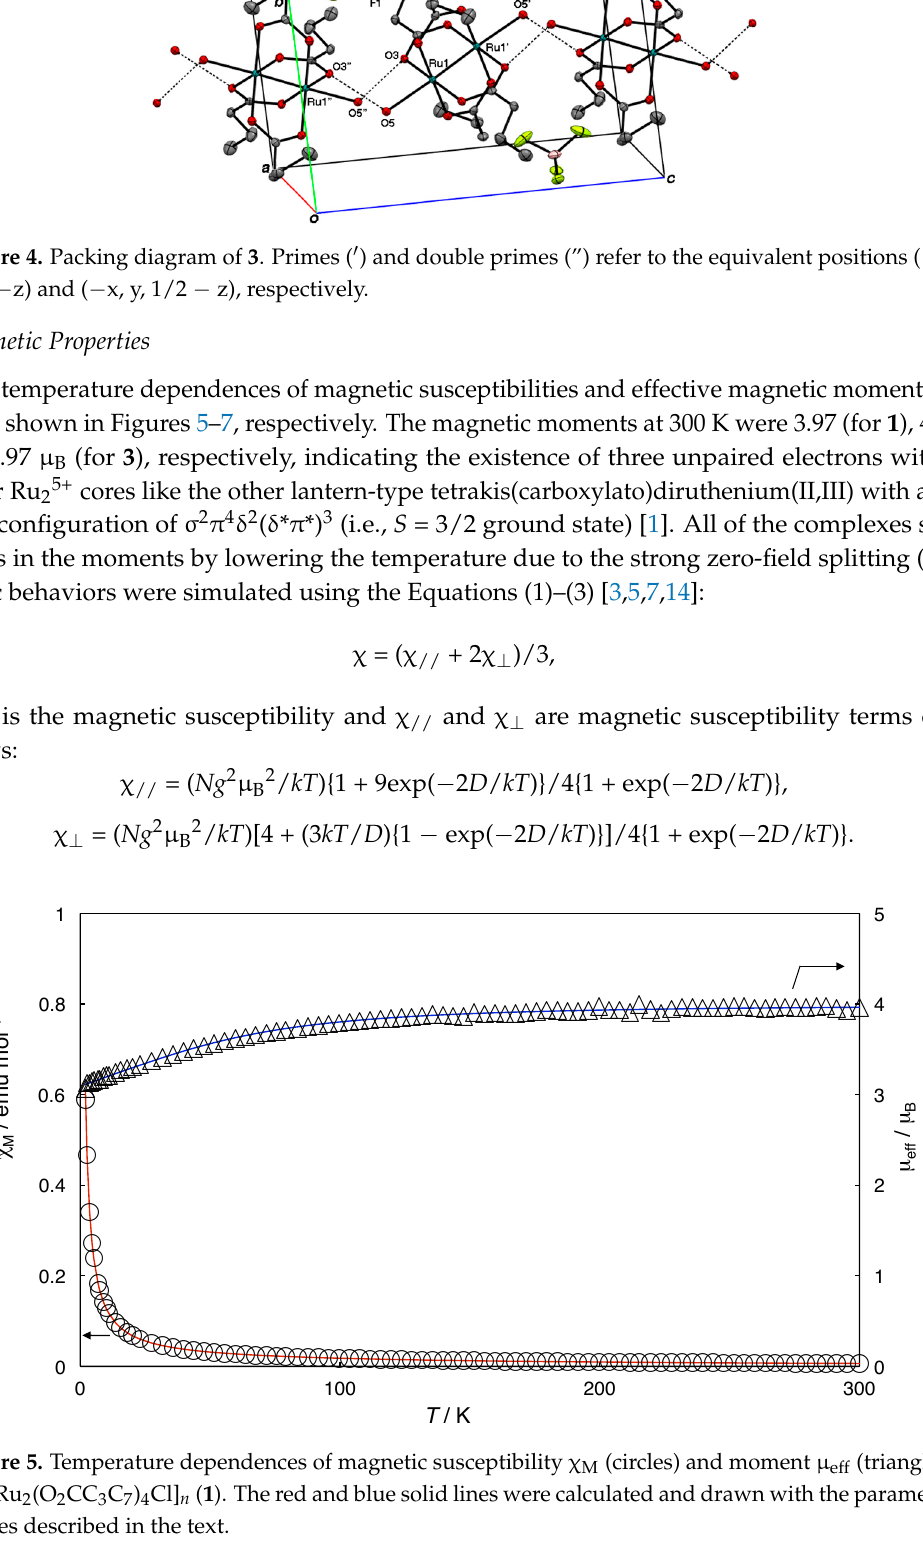
Figure 3. Structure of the cationic dinuclear unit of [Ru 2 (O 2 CC 3 H 7 ) 4 (H 2 O) 2 ]BF 4 ( 3 ). Hydrogen atoms were omitted for clarity. Primes ( ′ ) refer to the equivalent positions ( − x, − y, − z). The thermal ellipsoids are shown at the 50% probability level.